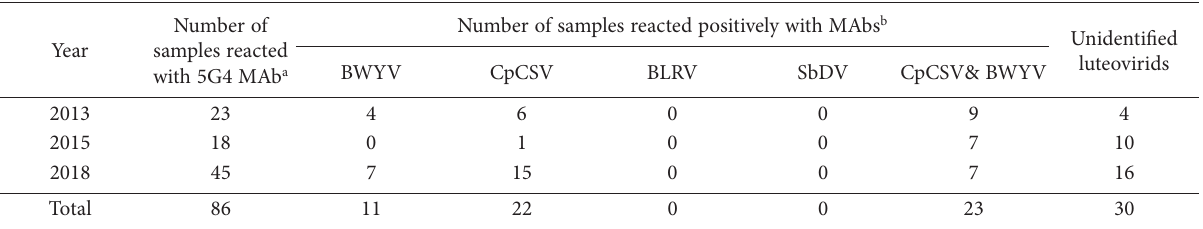
Table 3. Serological results of Tissue blot immunoassay (TBIA) with specific luteovirid monoclonal antibodies (MAbs) for chickpea samples collected from different regions of Sudan during the 2013, 2015 or 2018 growing seasons.